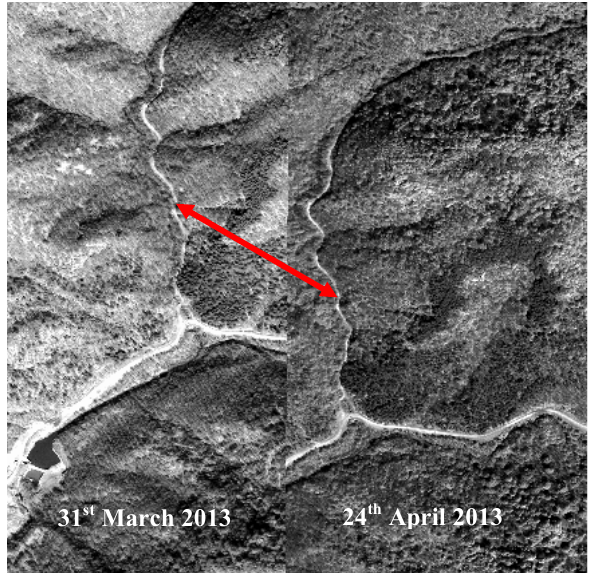
Figure 7. Systematic shift between two primary images. Magnitude of planimetric shift is about ±260 m.